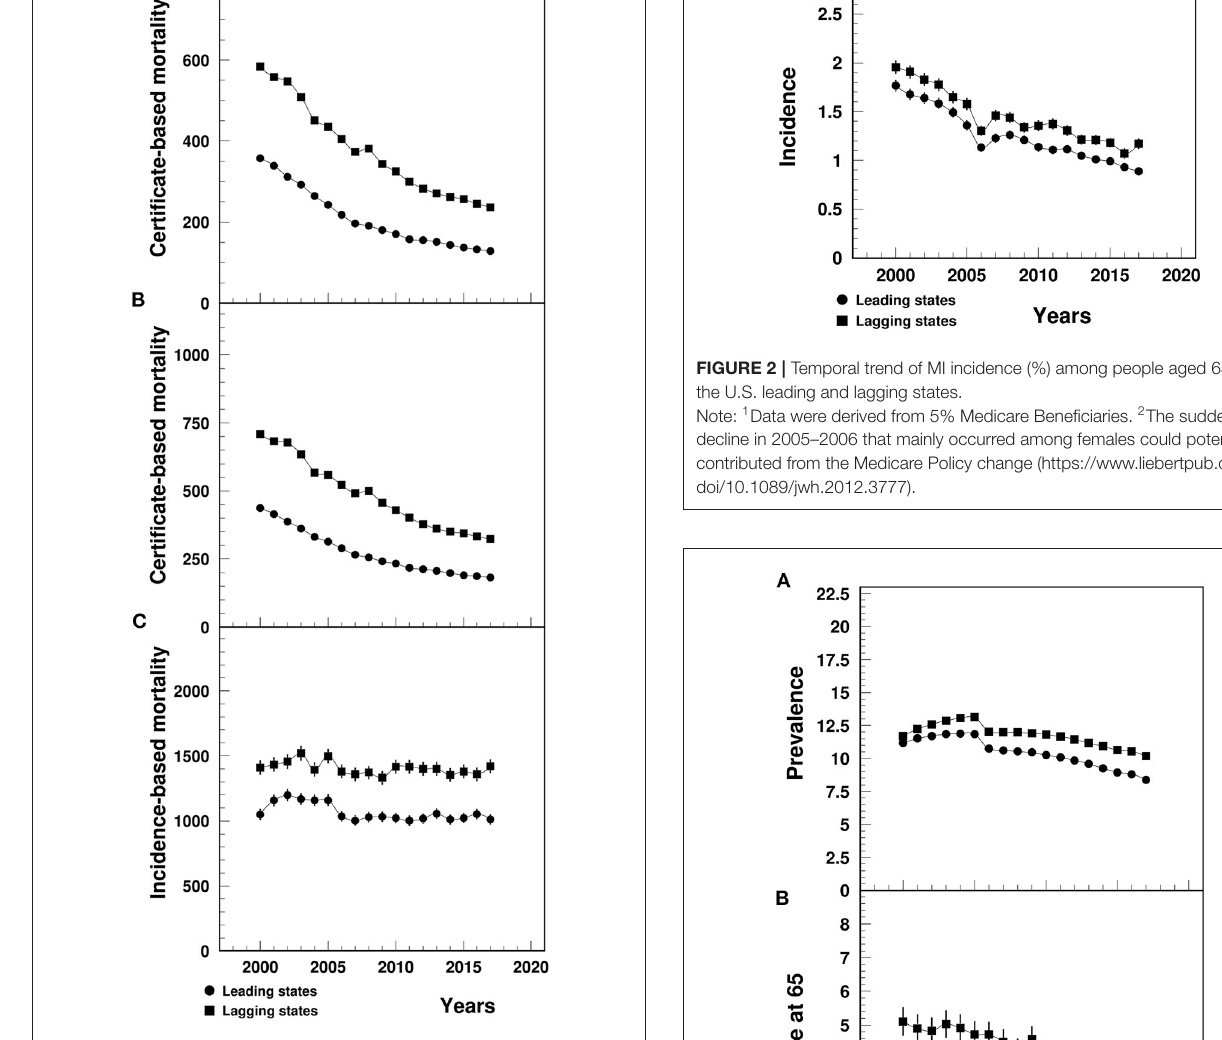
in 2017, narrower than the gap in the leading states (from 6.3